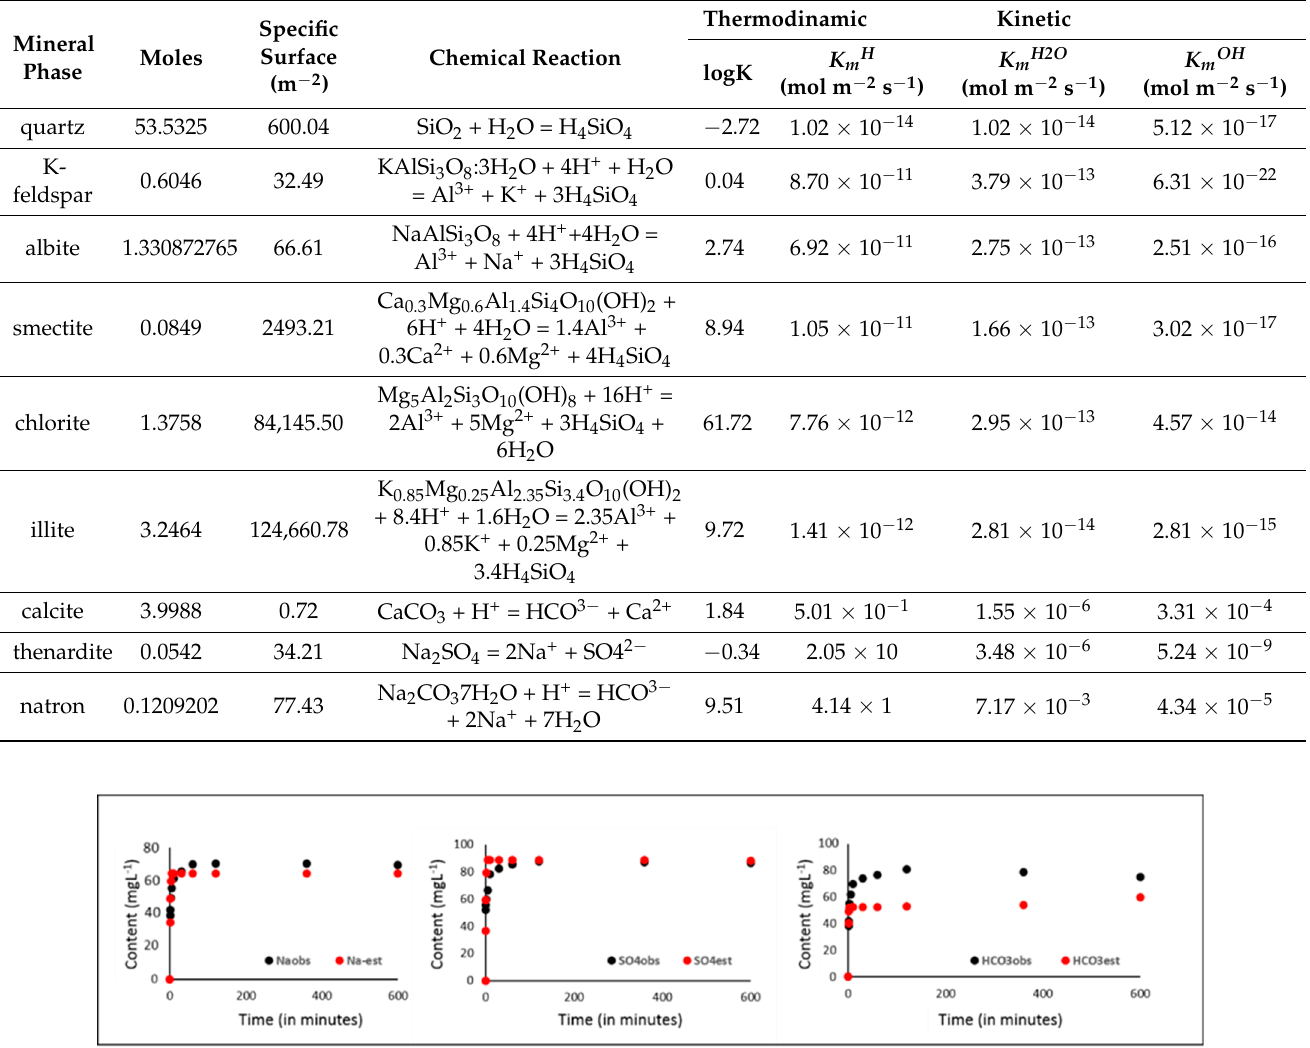
Table 4. Mineralogical assemblage of the kinetic modelling between pore water and soil sample S5 performed with the